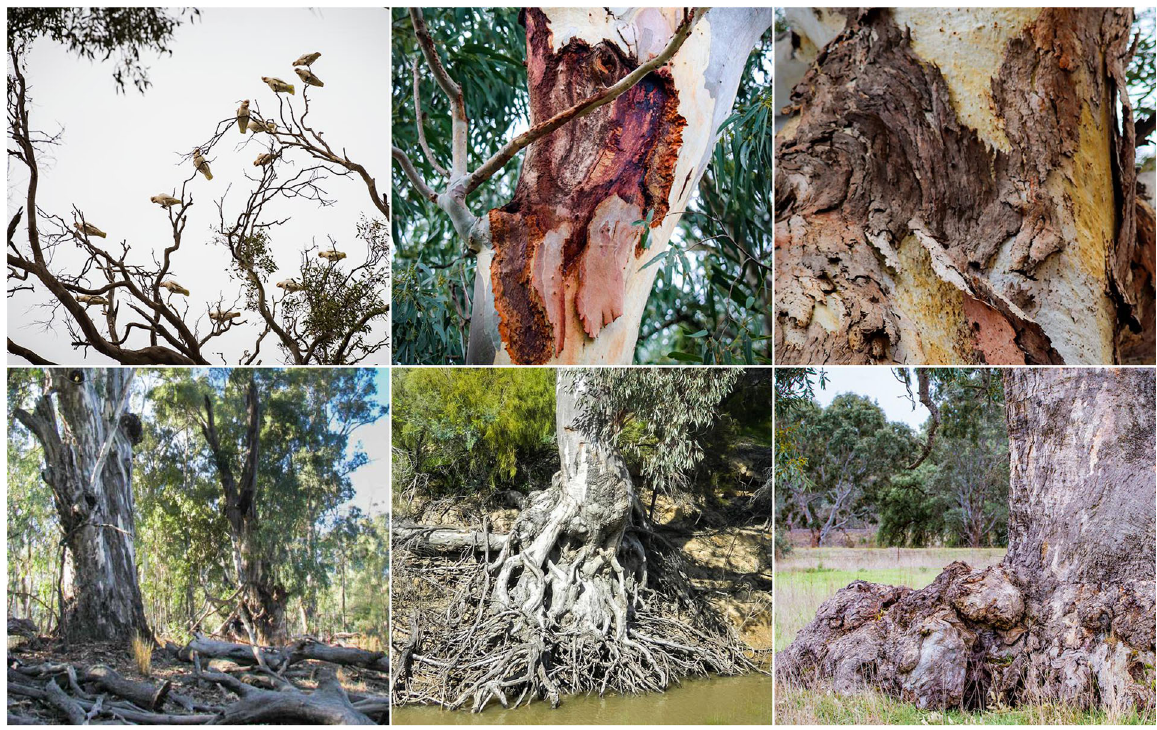
Fig. 3 Tree habitats. Examples of a range of supported by within river red gums. Top left: deadwood in the canopy. Top middle: damaged sapwood. Top right: rough bark. Bottom left: fallen limbs, bark and leaves in the understory (image by Kate Bennetts) Bottom middle: exposed roots. (image by Michelle Ridgeway) Bottom right: root buttresses (Source of all inattributed images: the